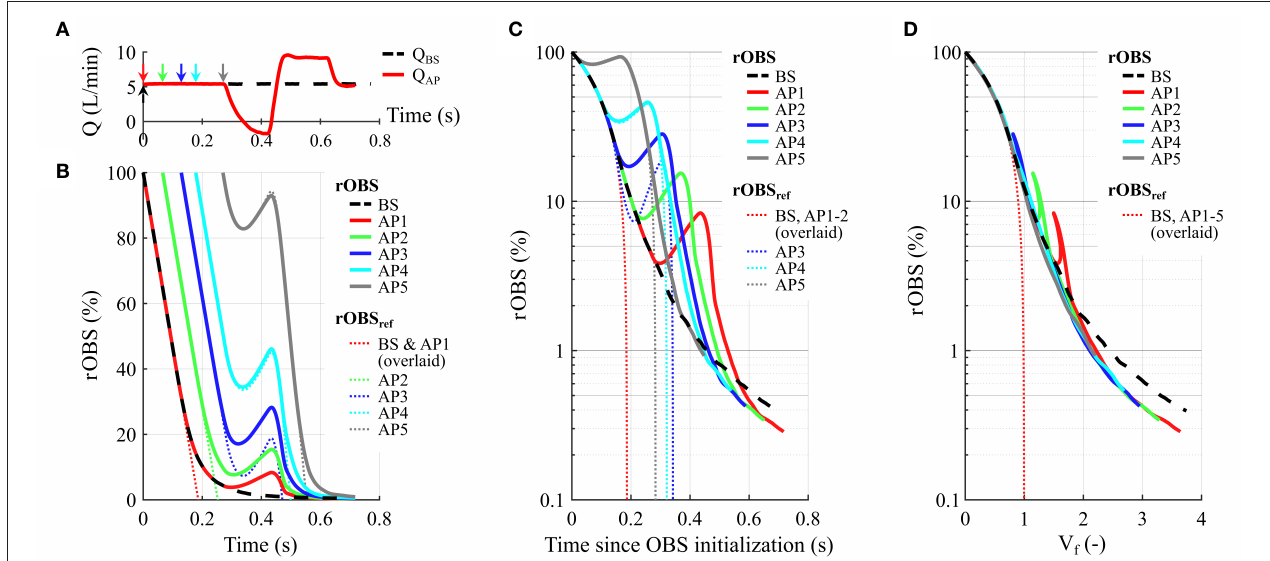
FIGURE 3 | Effect of the artificial pulse (AP) on the residual fraction of old blood scalar (rOBS). (A) Pump flow rate under baseline condition (BS) and with the AP. Arrows illustrate the different OBS initialization times using the same color coding as in (B–D) . Specifically, we consider one OBS for baseline (BS initialized in t = 0, black dashed arrow) and five different OBS initialization times with the AP (AP1–5, full colored arrows). (B) rOBS as a function of time (thick lines). For each OBS, the thin dotted lines illustrate the temporal evolution of the reference residual OBS concentration, rOBS ref , providing a reference for the best possible washout given the pump flow rate. (C) rOBS as a function of time since initialization. A logarithmic scale is used to visualize differences for rOBS below 5%. 99% washout times for BS and AP3–5 are comparable despite the AP flow reversal and reduced flush volume for AP3–5 as illustrated by the longer rOBS ref clearance times (thin dotted lines). (D) rOBS as a function of the flush volume, V f . Per definition, all the rOBS ref curves are overlaid depicting the best case scenario where one flush volume suffices to clear the pump. The “shark fin” feature corresponds to the AP flow reversal. The rotor acceleration and high-speed phase accelerate OBS washout for an equivalent flush volume as illustrated by the faster decline of rOBS for AP1–5 compared to baseline. The rOBS time course for all the simulated scenario, including high- and low-flow conditions, is given in Supplementary Material S3 .